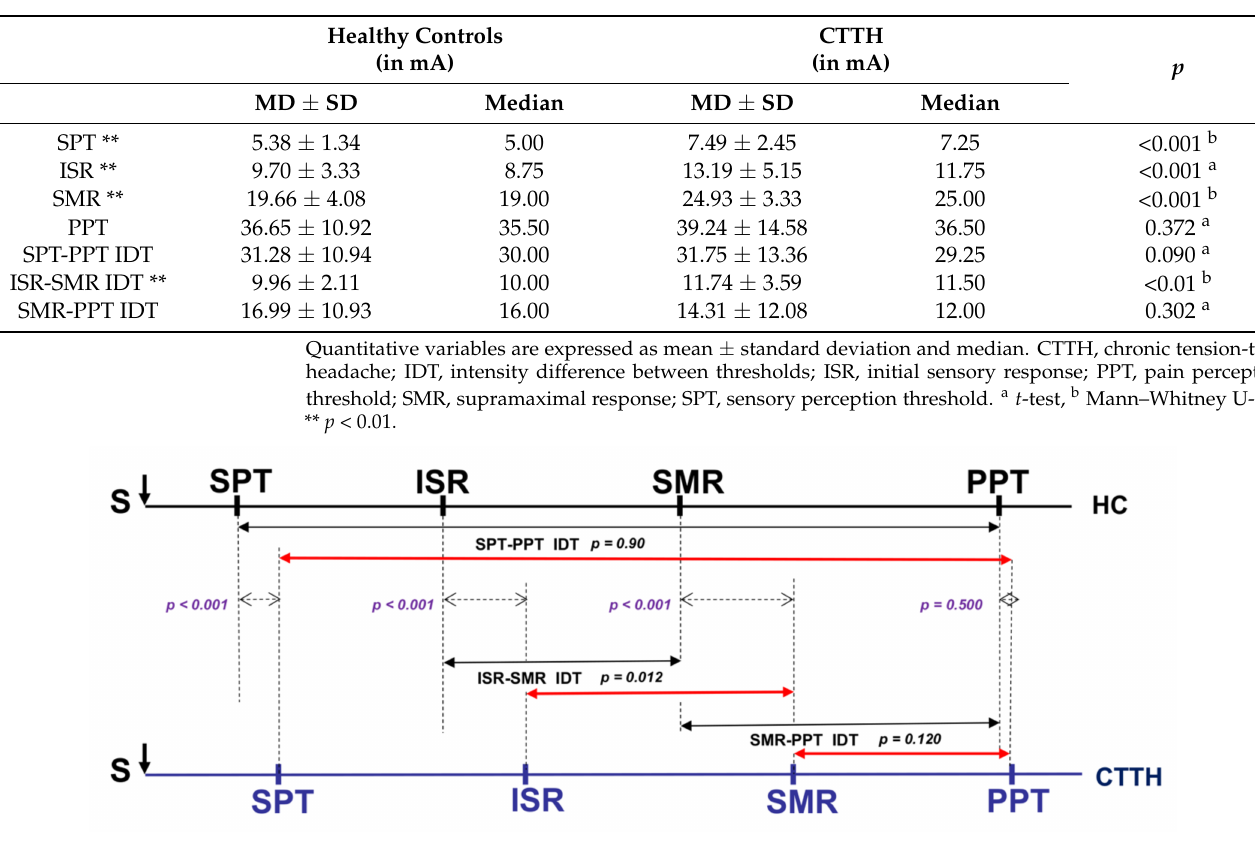
Figure 3. Comparison of sensory responses to electrical stimuli in CTTH patients and healthy controls. CTTH, chronic tension-type headache; HC, healthy control; IDT, intensity difference between thresholds; ISR, initial sensory response; PPT, pain perception threshold; S, stimulus; SMR, supramaximal response; SPT, sensory perception